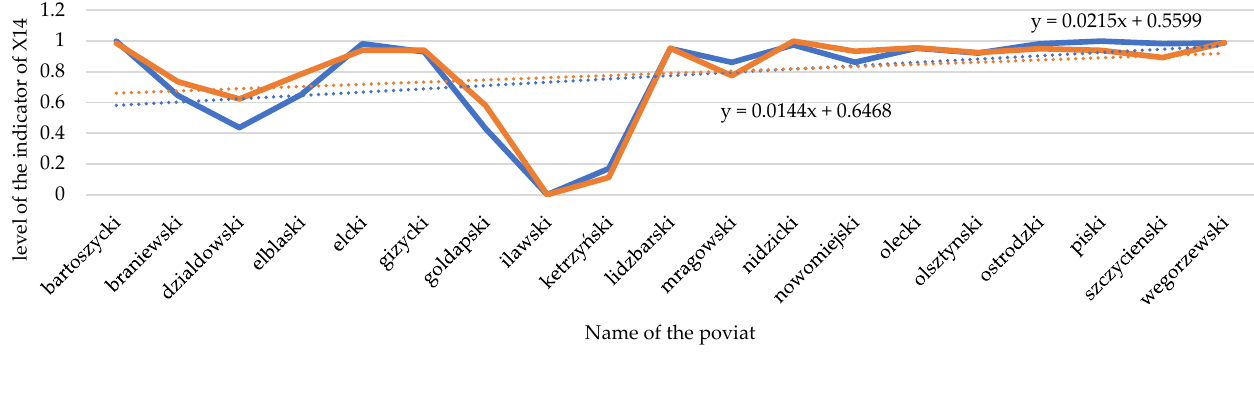
Figure 6. Changes in the index of greenhouse gas emissions (X14) in individual spatial units (tons/per year). Source: own study on [104].